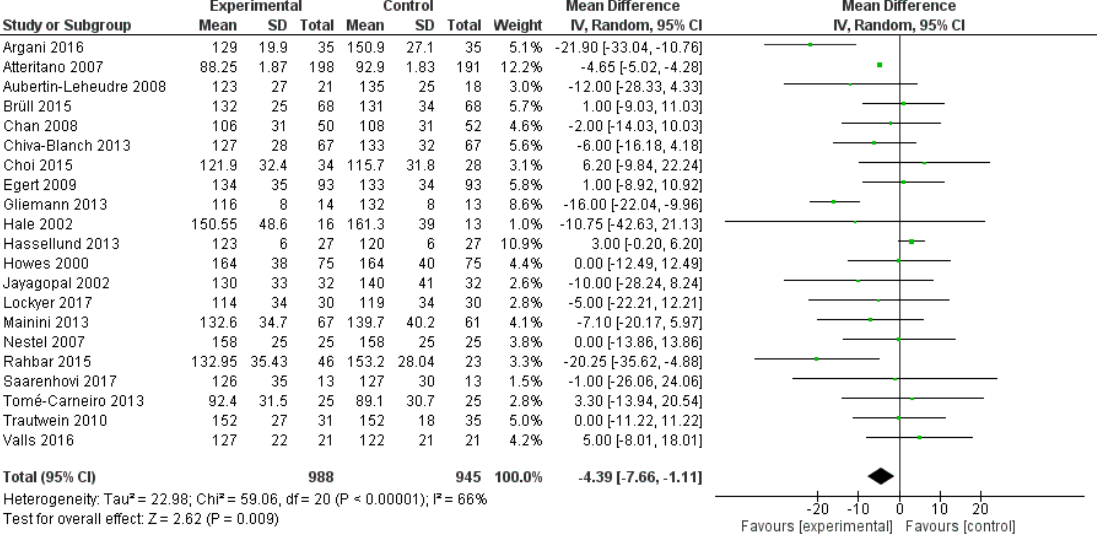
Figure 5. Pooled analysis of association between polyphenol intake and low-density lipoprotein cholesterol (LDL-C).